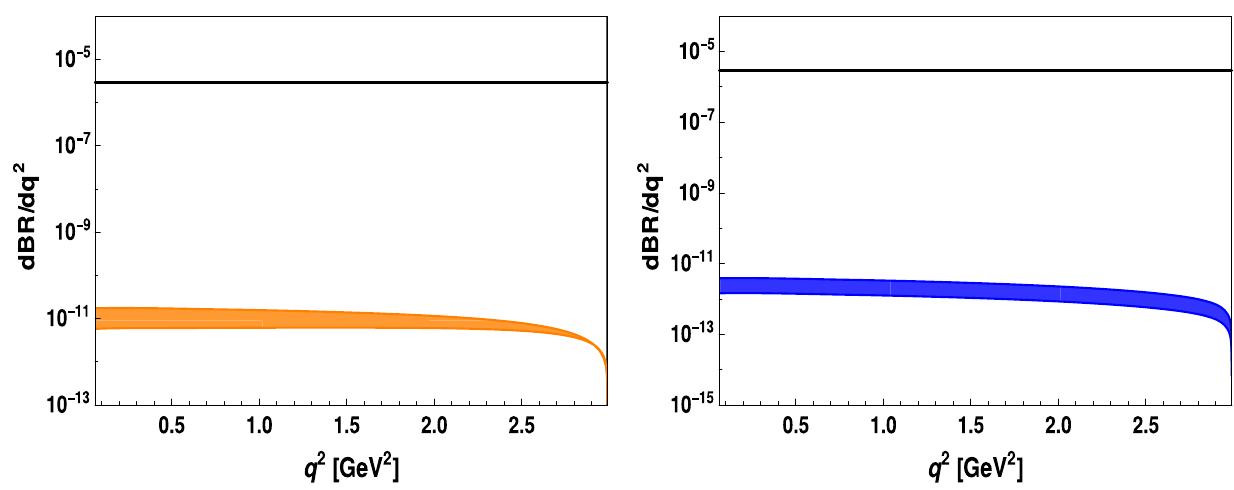
Fig. 6 The variation of branching ratio of the LFV process D + → π + μ − e + in the leptoquark model ( left panel ) and generic Z (cid:2) model ( right panel ) with respect to q 2 . The solid black lines represent the 90% CL experimental upper bound [60]